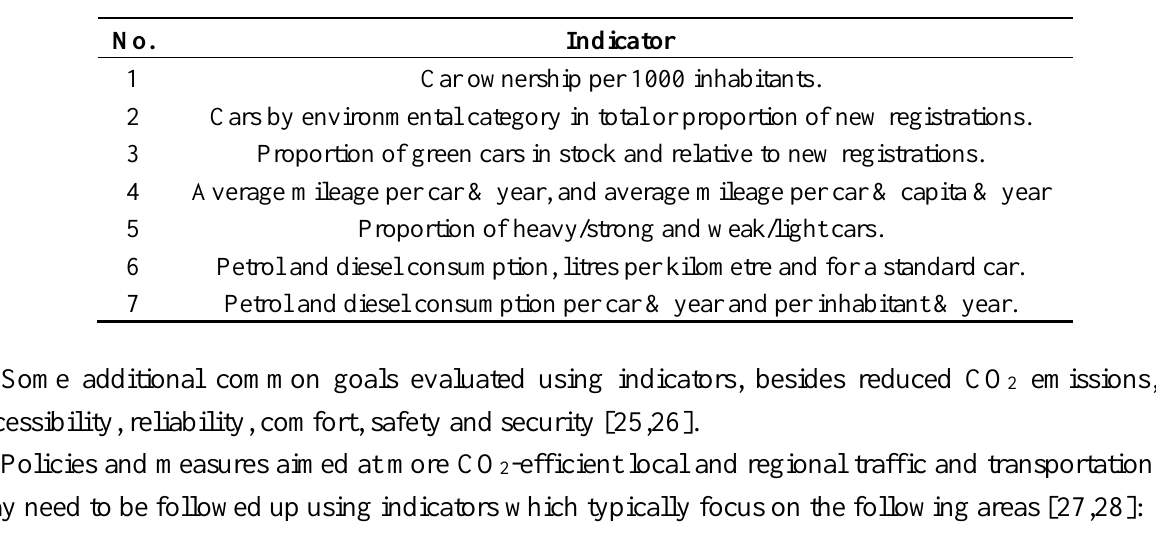
Table 2. Seven transport indicators that can be applied at municipal or regional